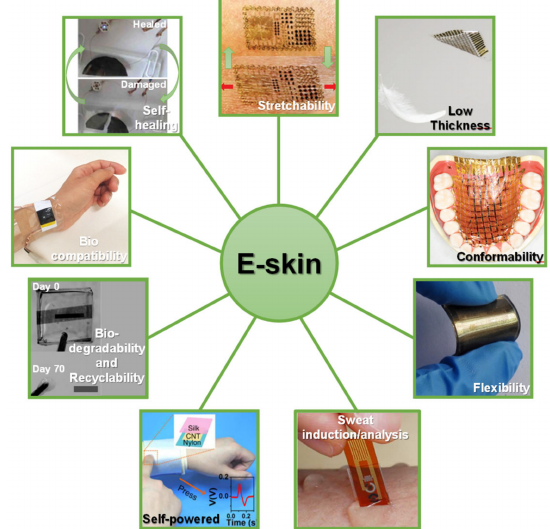
Figure 1. E-skin key features. Images adapted from: self-healing [16] (Copyright © 2020, Springer Nature), stretchability [17] (Copyright © 2020, The American Association for the Advancement